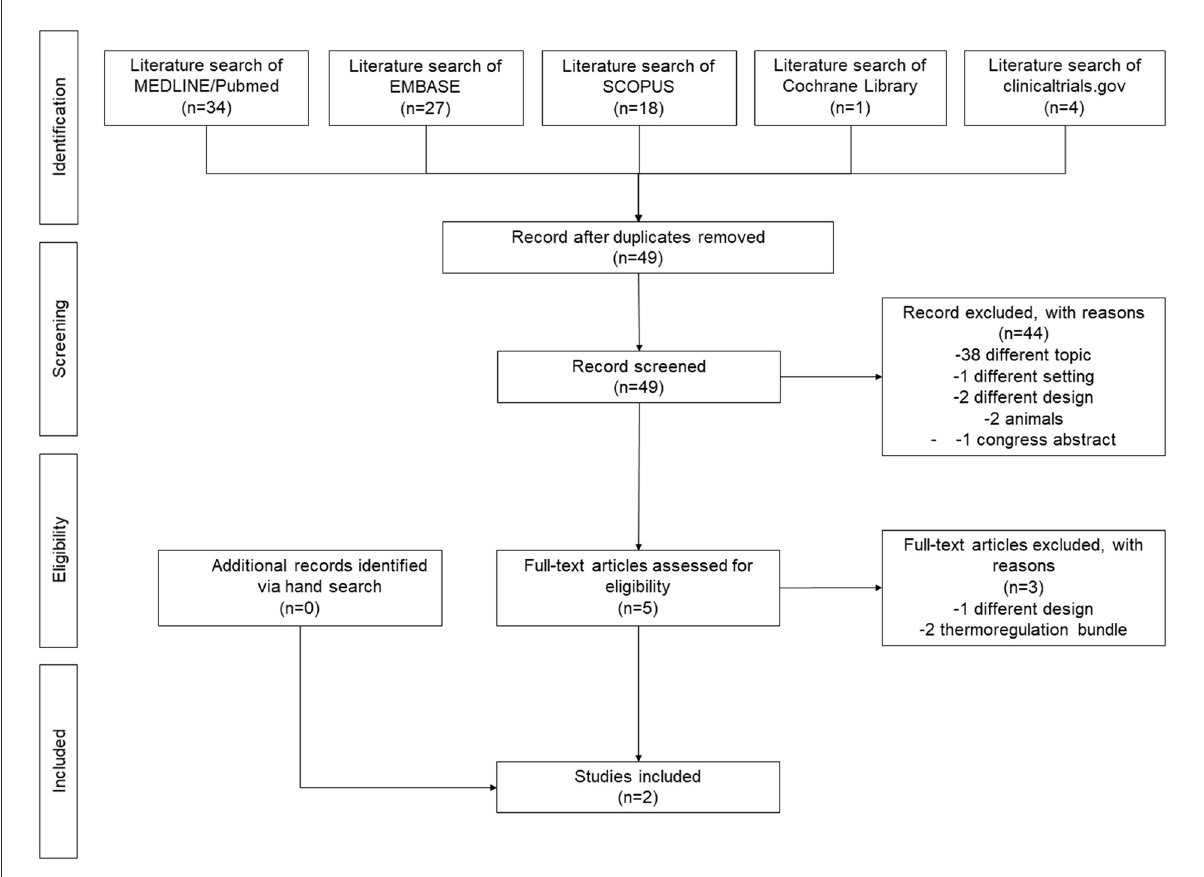
FIGURE1 PRISMA flow